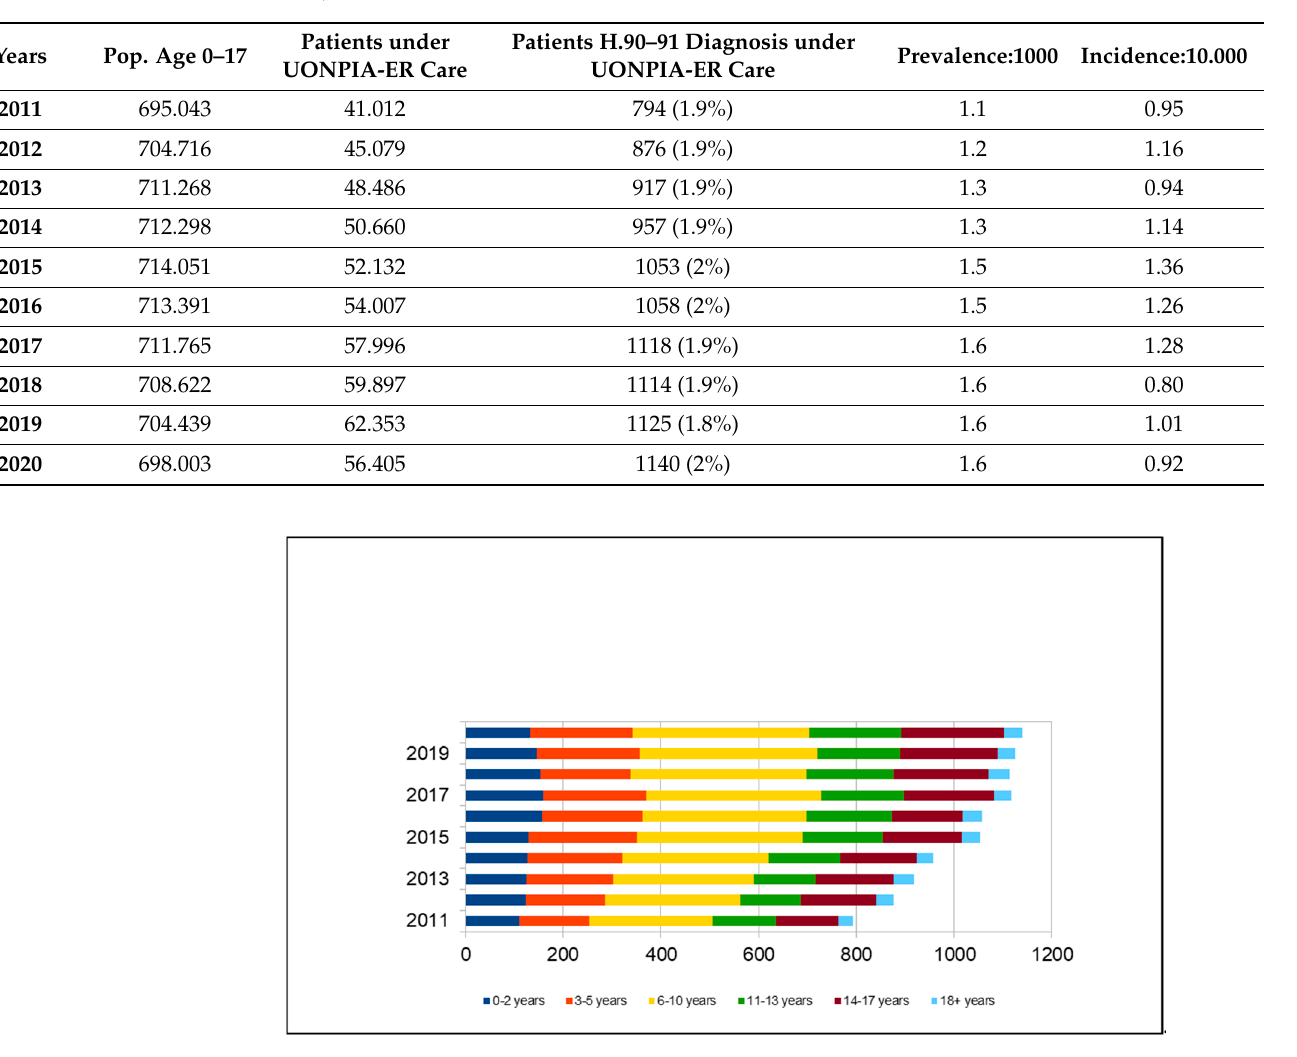
Table 1. Prevalence and incidence of hearing loss in the juvenile population and in CAMHS users. Due to small numbers, incidence was measured as 1:10,000 instead of 1:1000.